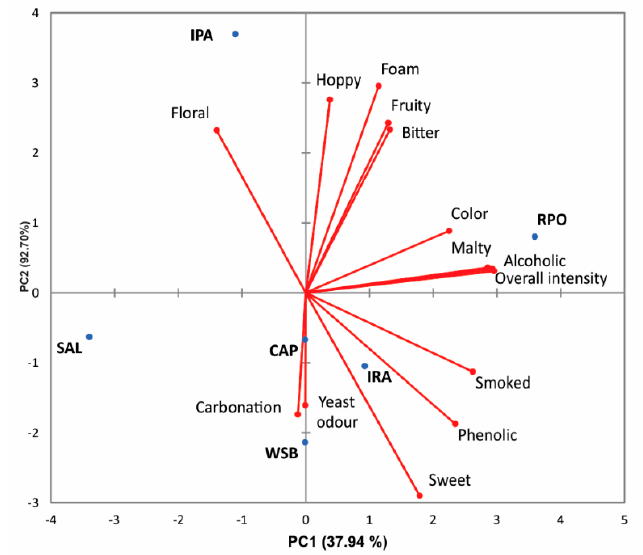
Figure 2. Scatter plots of principal component analysis (PCA) scores for specific sensory attributes of Southern Brazilian craft beers analyzed in the present study. (PC1 + PC2 explain 67.64% of total matrix variance). Standard American lager (SAL), Classic American pilsner (CAP), weissbier (WSB), American India pale ale (IPA), Irish red ale (IRA), and robust porter (RPO).